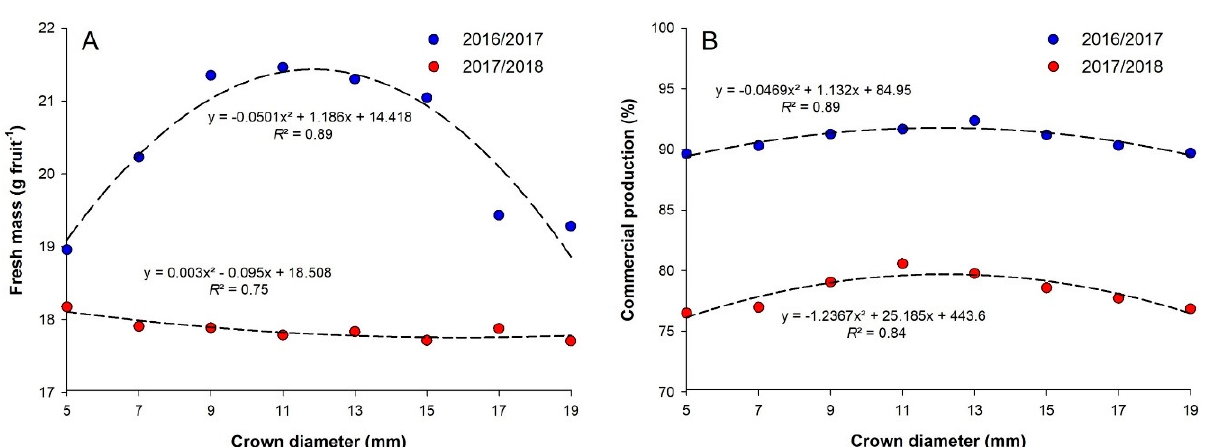
Figure 3. The response of fresh fruit mass ( A ) and the percentage of production classified as commercial ( B ) of strawberry plants cv. ‘Pircinque,’ depending on different plant crown diameters (5, 7, 9, 11, 13, 15, 17, and 19 mm) in the production cycles 2016/2017 and 2017/2018.